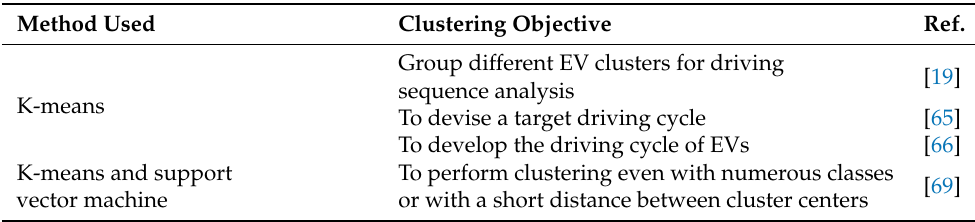
Table 4. Summary of clustering methods along with their objectives for driving cycle analysis of EVs. Method